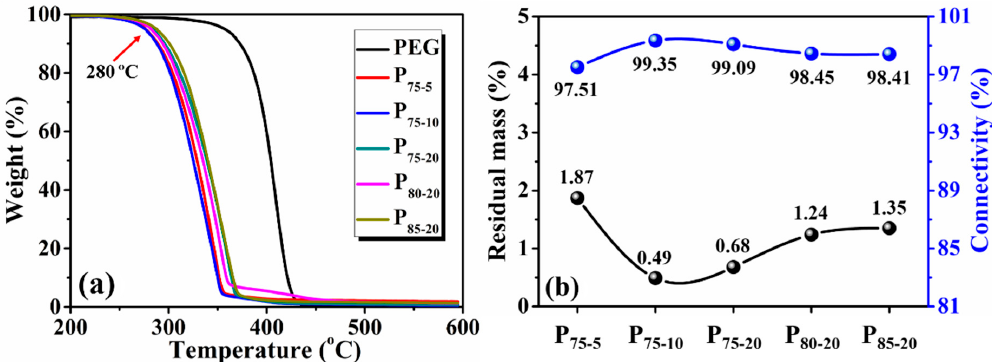
Figure 3. ( a ) TGA curves of porous PLA scaffolds and PEG control; ( b ) Residual mass and connectivity as a function of sample composition.